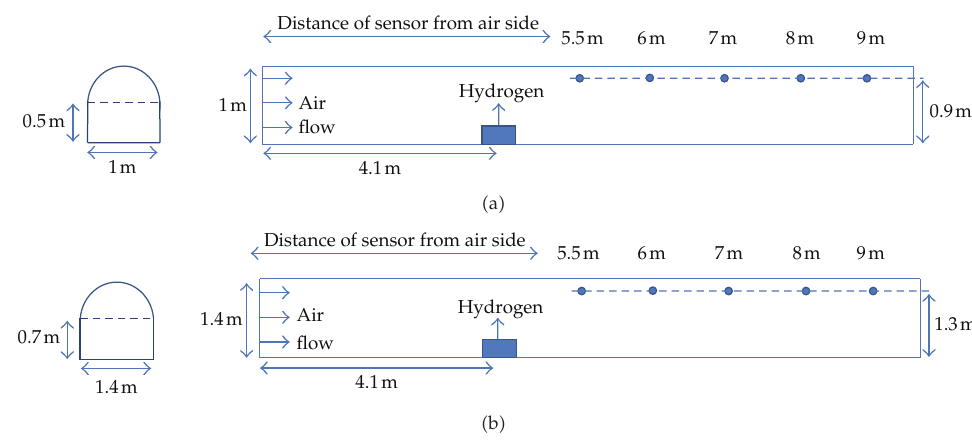
Figure 2: Schematic diagrams of Models 1 and 2 (cid:2) not to scale (cid:3)